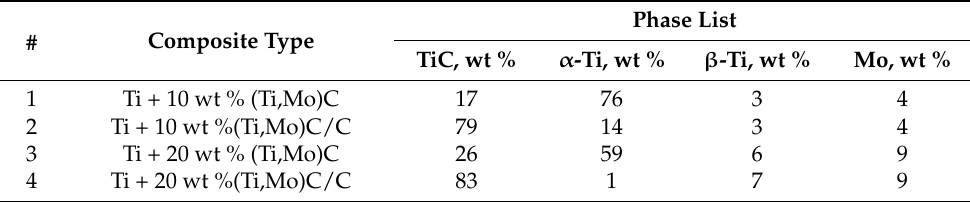
Table 1. Percentage of the identified phases.